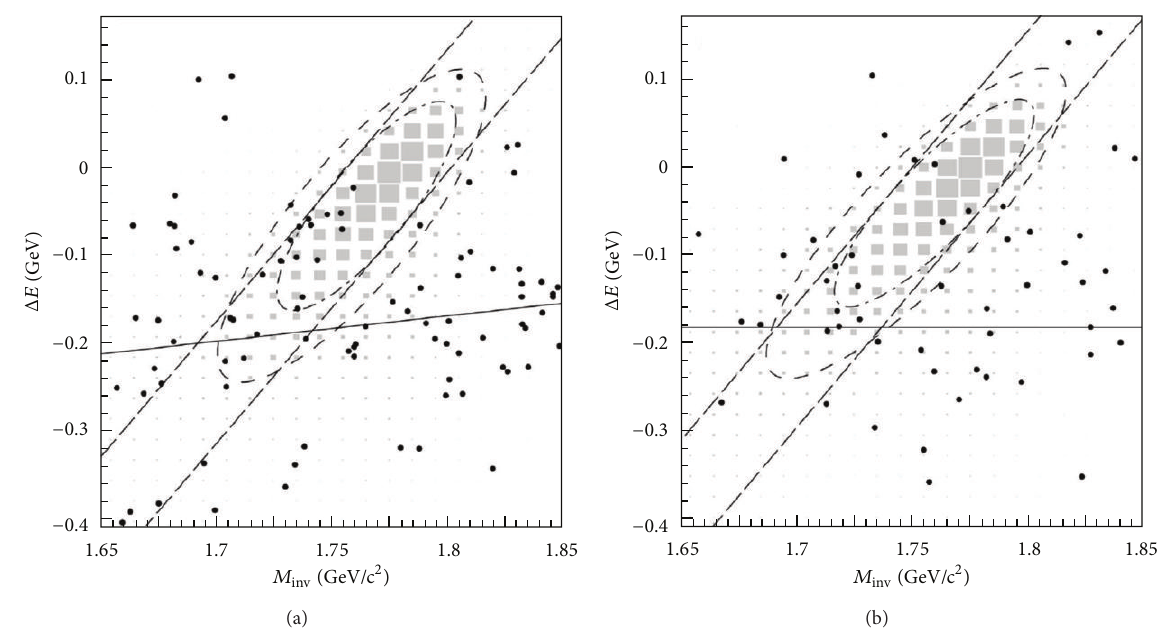
Figure 32: Results of the Belle search for 𝜏 → 𝜇𝛾 (a) and 𝜏 → e 𝛾 (b) CLFV decays